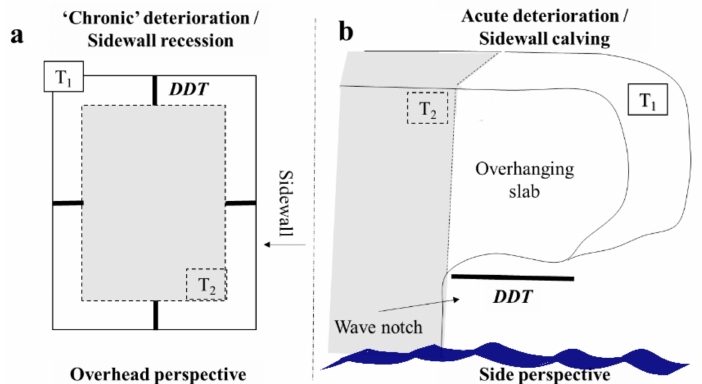
Figure 9. Example of idealized ice loss due to the two general ice island deterioration types: ( a ) ‘chronic’ deterioration occurring between Time 1 (T 1 ) and Time 2 (T 2 ), assuming here that all sidewalls recede at a slower rate than ( b ) ‘acute’ deterioration that occurs at a specific location between T 1 and T 2 . The example of acute deterioration in ( b ) is the calving of an overhanging slab that is created through chronic wave erosion at the